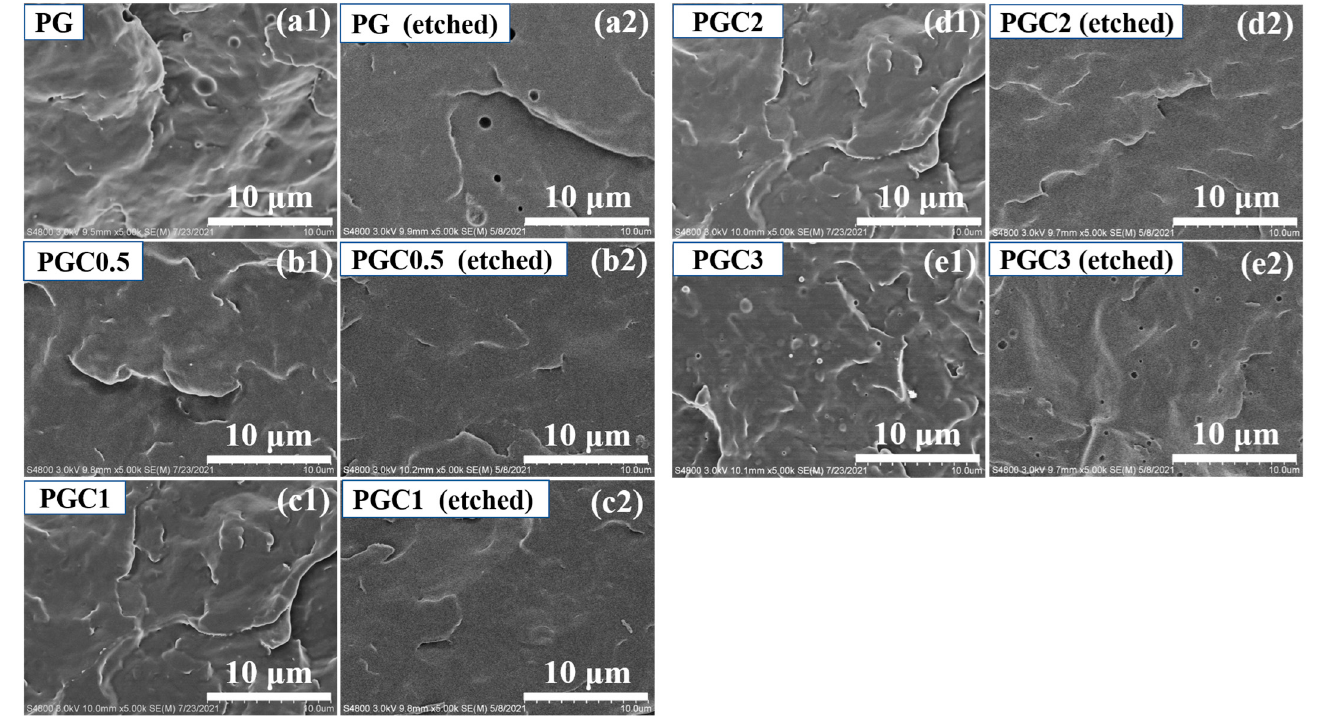
Figure 1. SEM images of the cross-fracture surface of the PP/DCP/GMA/C blends with different tea polyphenols (C) loading before ( a 1– e 1) and after ( a 2– e 2) etching. polyphenols (C) loading before ( a1 – e1 ) and after ( a2 – e2 )